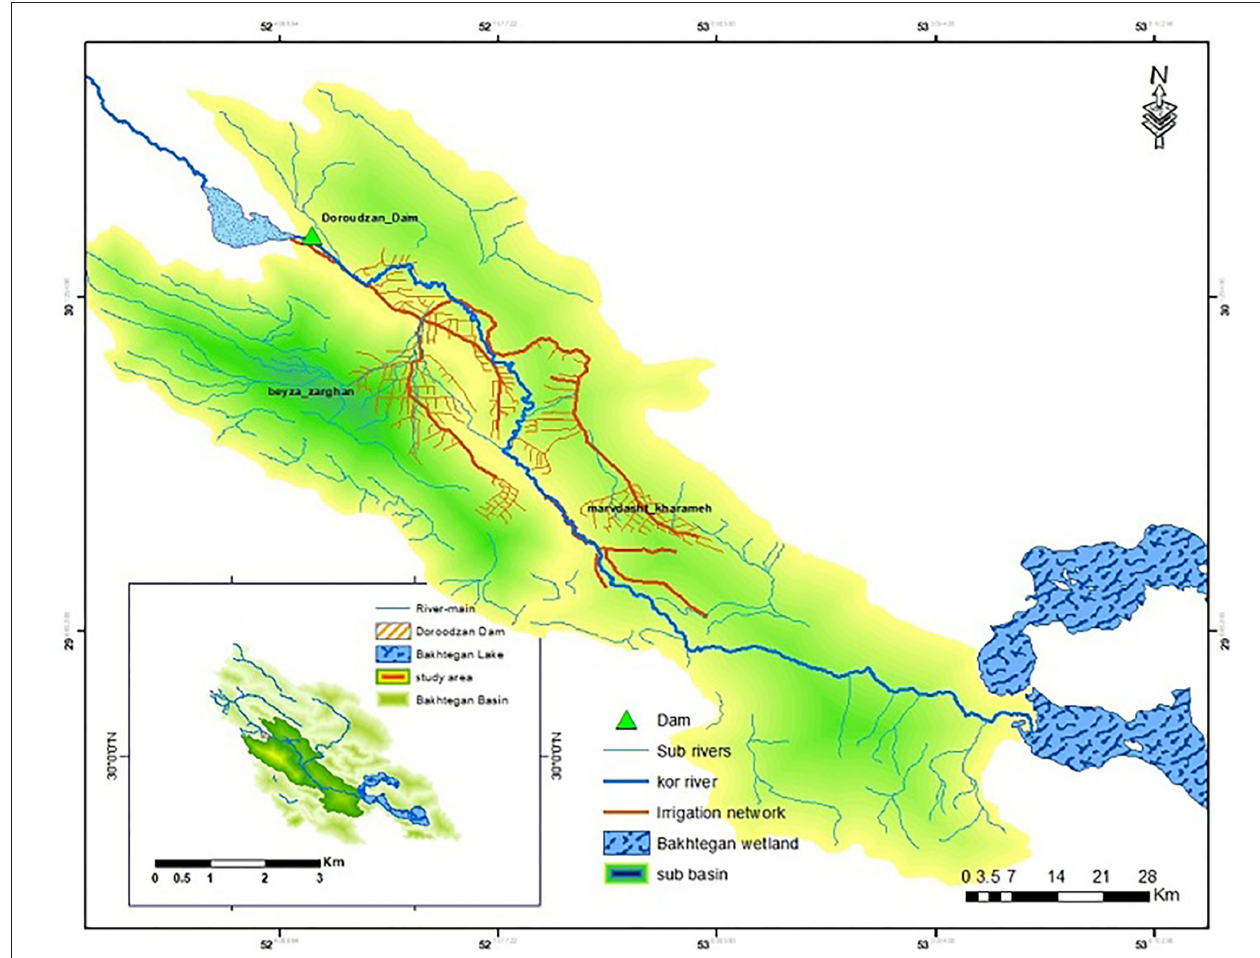
FIGURE 2 | Location of the study